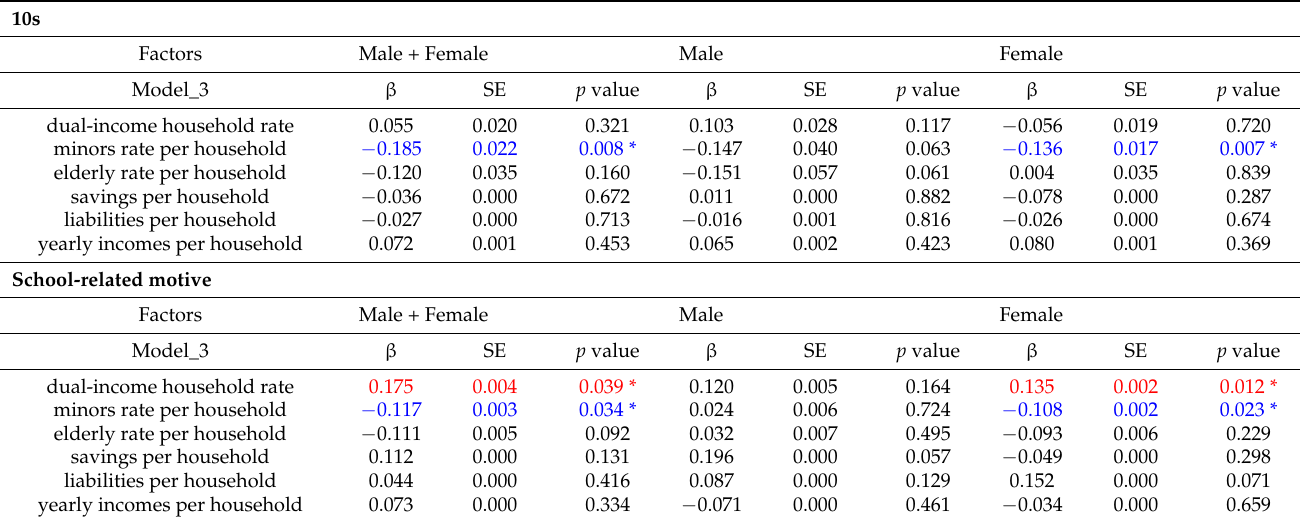
Table 2. Impacts of dual-income household rate and household structural factors (Model_3) on suicide mortalities of Male + Female, Male and Female in their 10s and caused by school-related motive between 2009 and